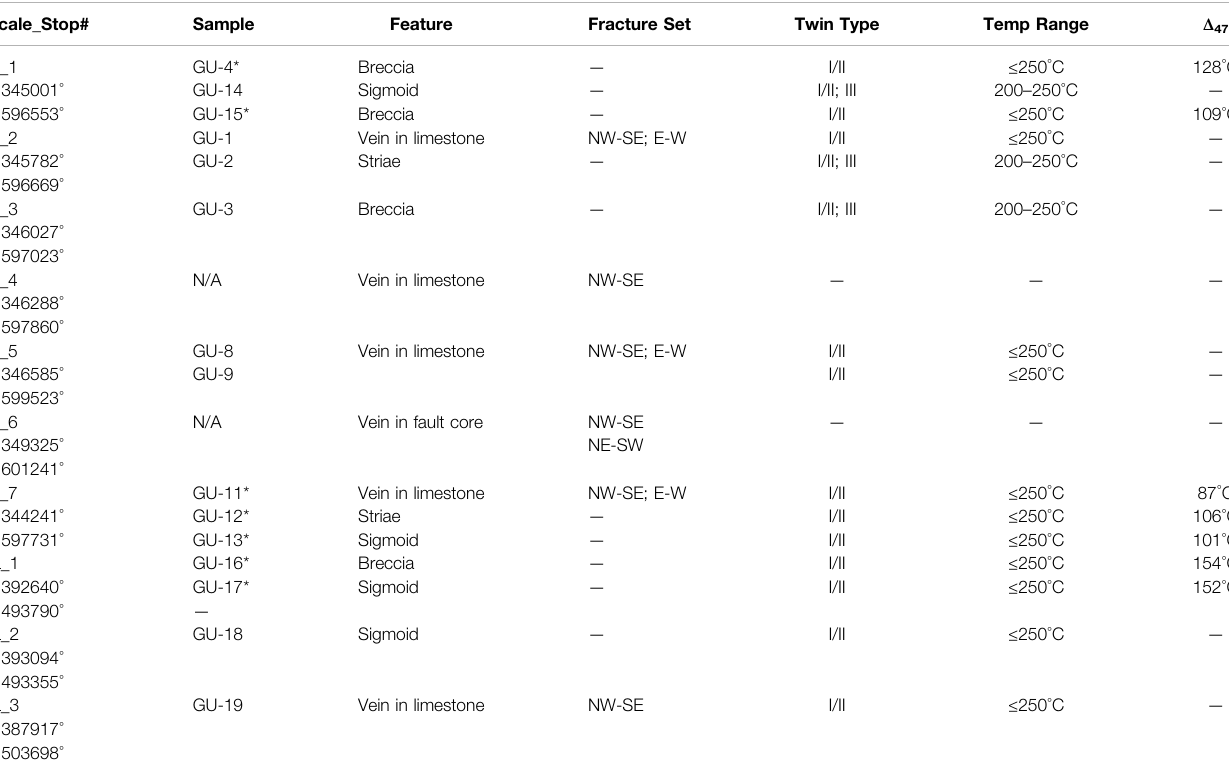
TABLE 1 | List of samples collected from the GL and ML localities. Where applicable, observations of vein features and fracture sets, observed calcite twin types and associated temperature values (e.g., Burkhard, 1993; Ferrill et al., 2004), and clumped isotope temperatures are provided. Calcite twin types are grouped morphologicallyandannotatedasfollows:TypeIandIItwinsaregroupedtogetheras “ I/II ” ,TypeIIItwinsareseparatedanddenotedas “ III ” .Theasterisk(*)indicatessamples that were used for clumped isotope